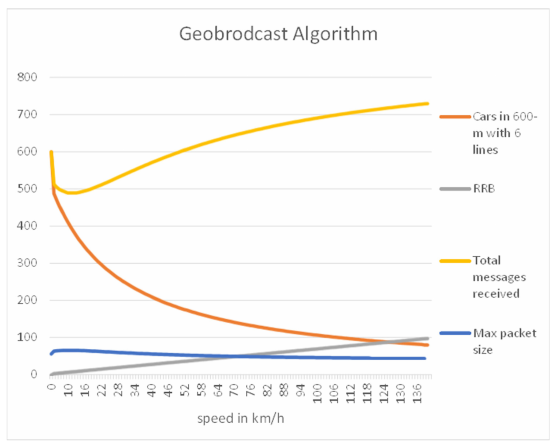
Figure 6. Proposed